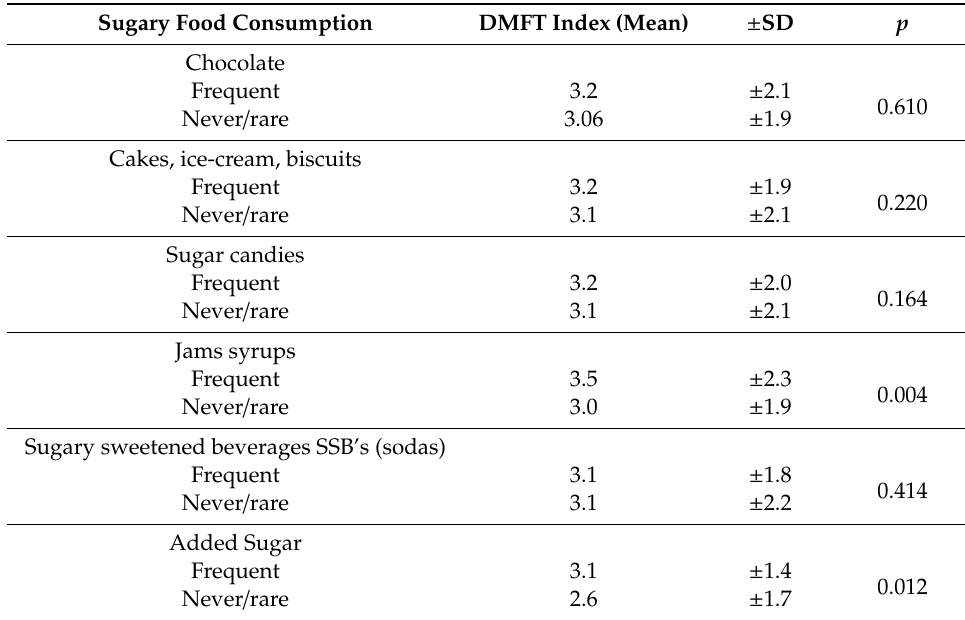
Table 4. Bivariate analysis between sugary food consumption and DMFT